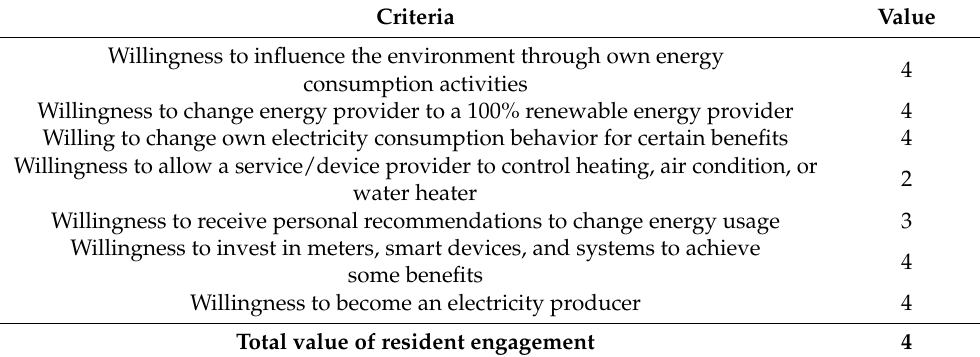
Table 7. The evaluated criteria for the resident engagement to climate conscious actions. Criteria Value Willingness to influence the environment through own energy consumption activities